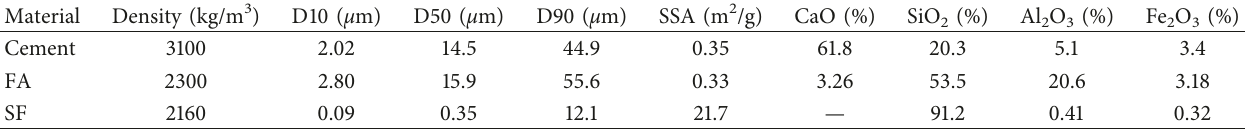
Table 1: Physical properties and chemical composition of raw materials.